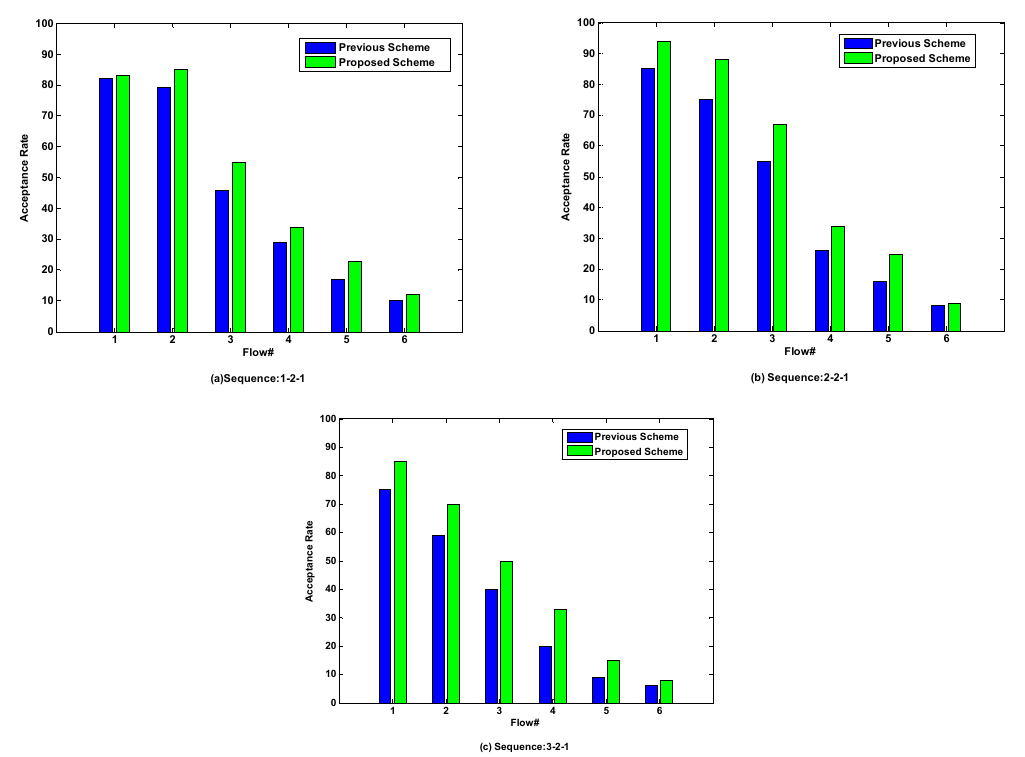
Figure 7. Simulation results for w.r.t IntraSend time slots.